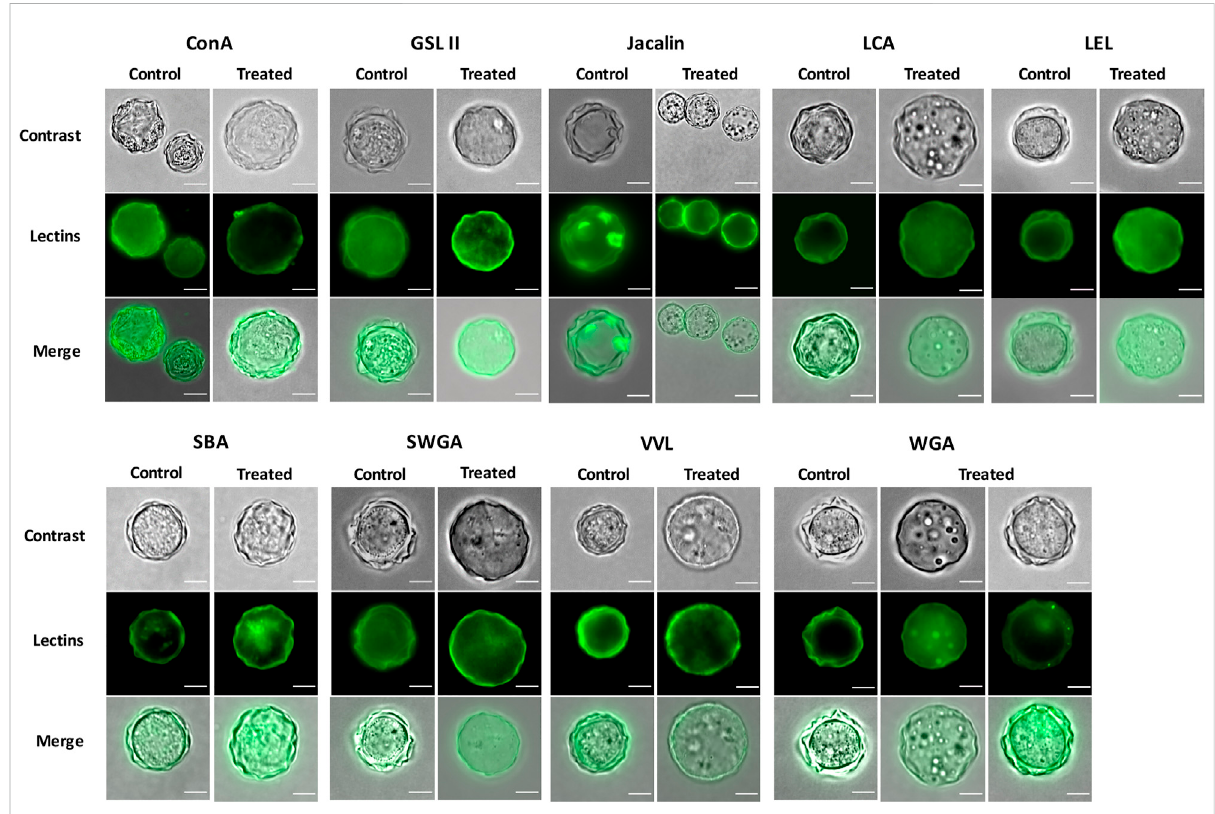
FIGURE 7 In fl uence of cellulase treatment on carbohydrate localization in A. castellanii cysts. After a treatment in the presence or absence (control) of 7.5 U/mL cellulase at 27 ° C for 48 h, carbohydrates were labeled by FITC-lectins (green). Phase contrast and merge images are shown on top and at the bottom of the FITC-lectin image, respectively. Nine lectins were used in this experiment: Con A, GSL II, Jacalin, LCA, LEL, SBA, SWGA, VVL and WGA. Scale bars = 10